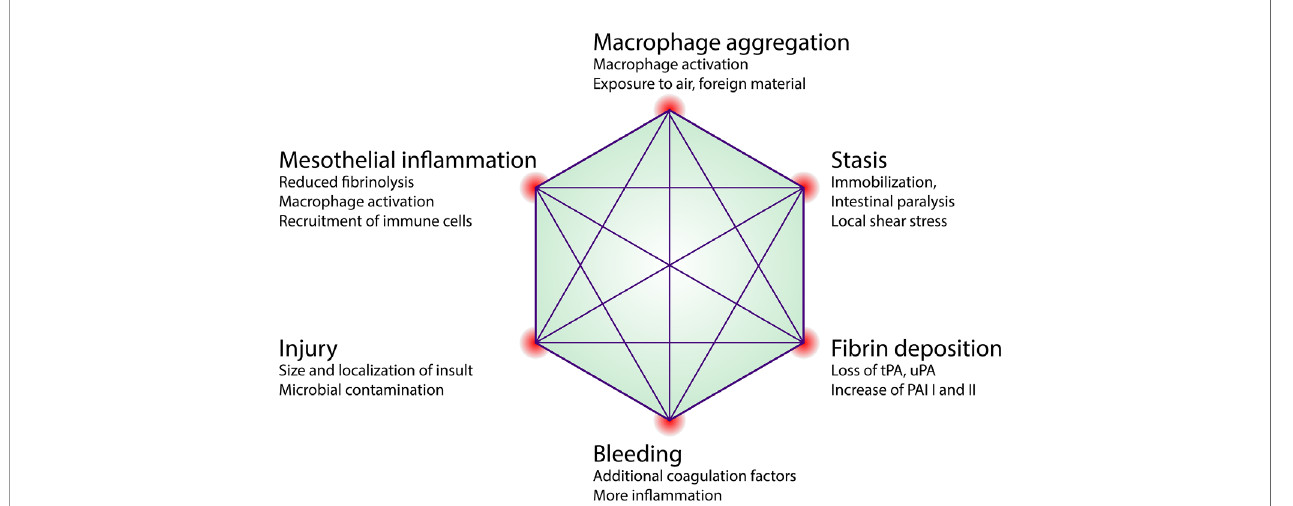
FIGURE 5 | Factors in fl uencing adhesion formation. Proposed concept of early local determinants that in fl uence the binary outcome of adhesion formation and may be exploited therapeutically. tPA, tissue plasminogen activator; uPA, urokinase-type plasminogen activator; PAI, Plasminogen activator